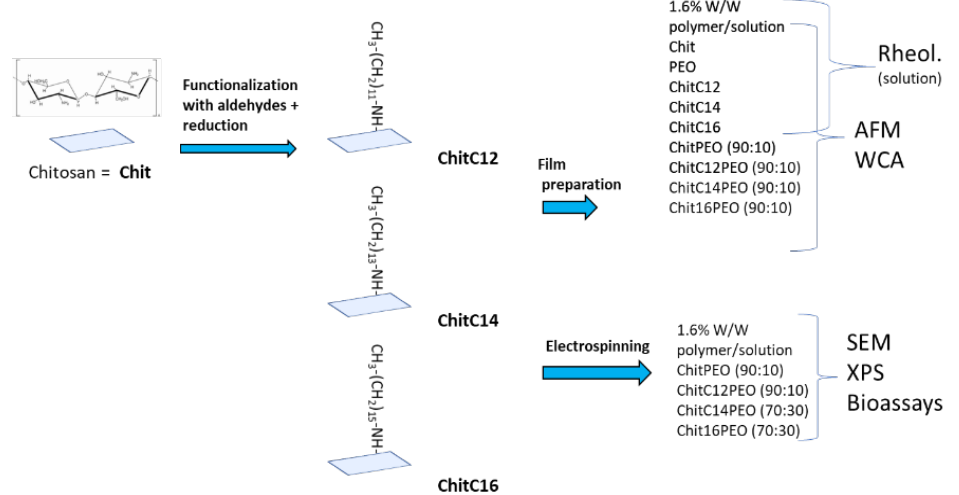
Figure 1. Schematic representation of the experimental plan with abbreviations.